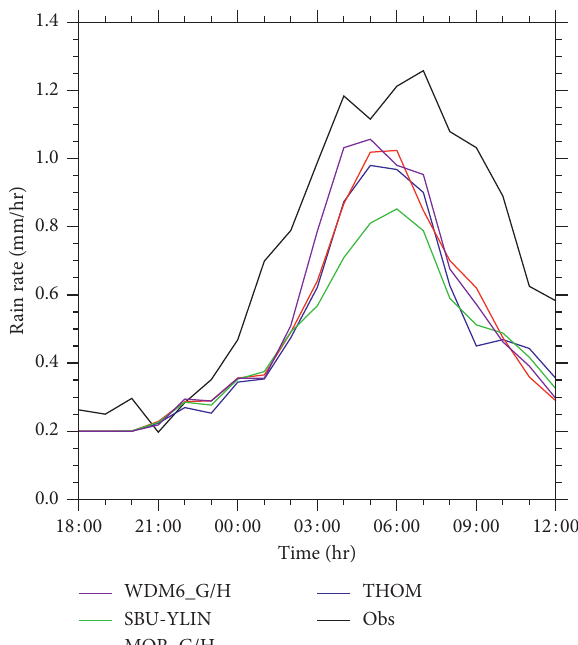
Figure 5: Hourly surface precipitation rate averaged within the region (107–117 ° E, 27–35 ° N) from the observations (black solid curve) and the simulations of THOM (blue curve), MOR_G/H (red curve), SBU-YLIN (green curve), and WDM6_G/H (purple